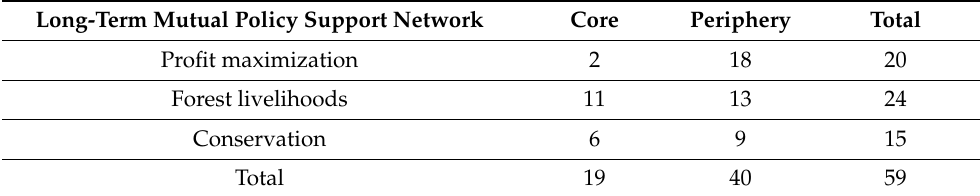
Table 3. Distribution of core beliefs across core and periphery.